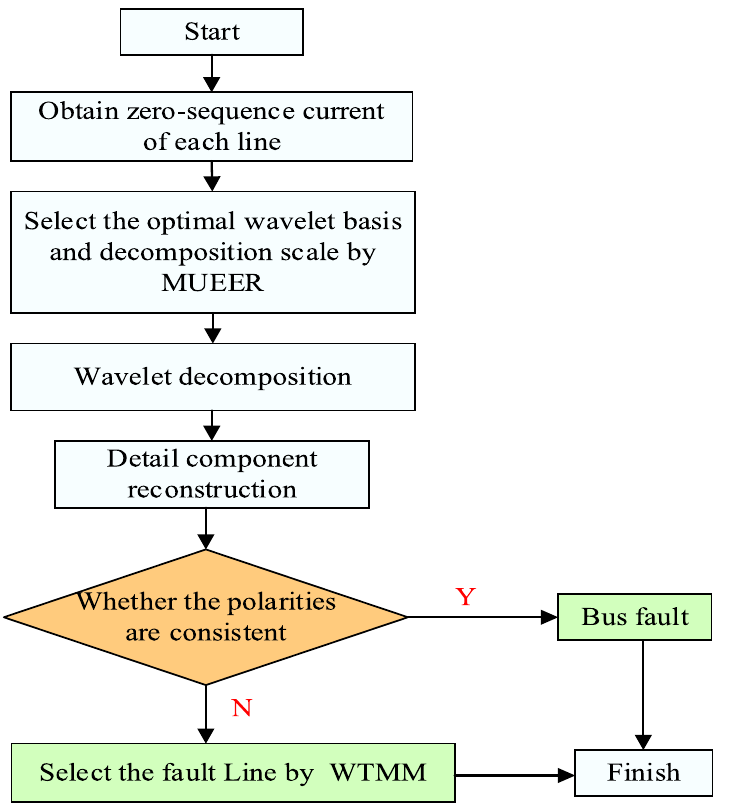
Fig. 3 Flow chart of WTMM protection